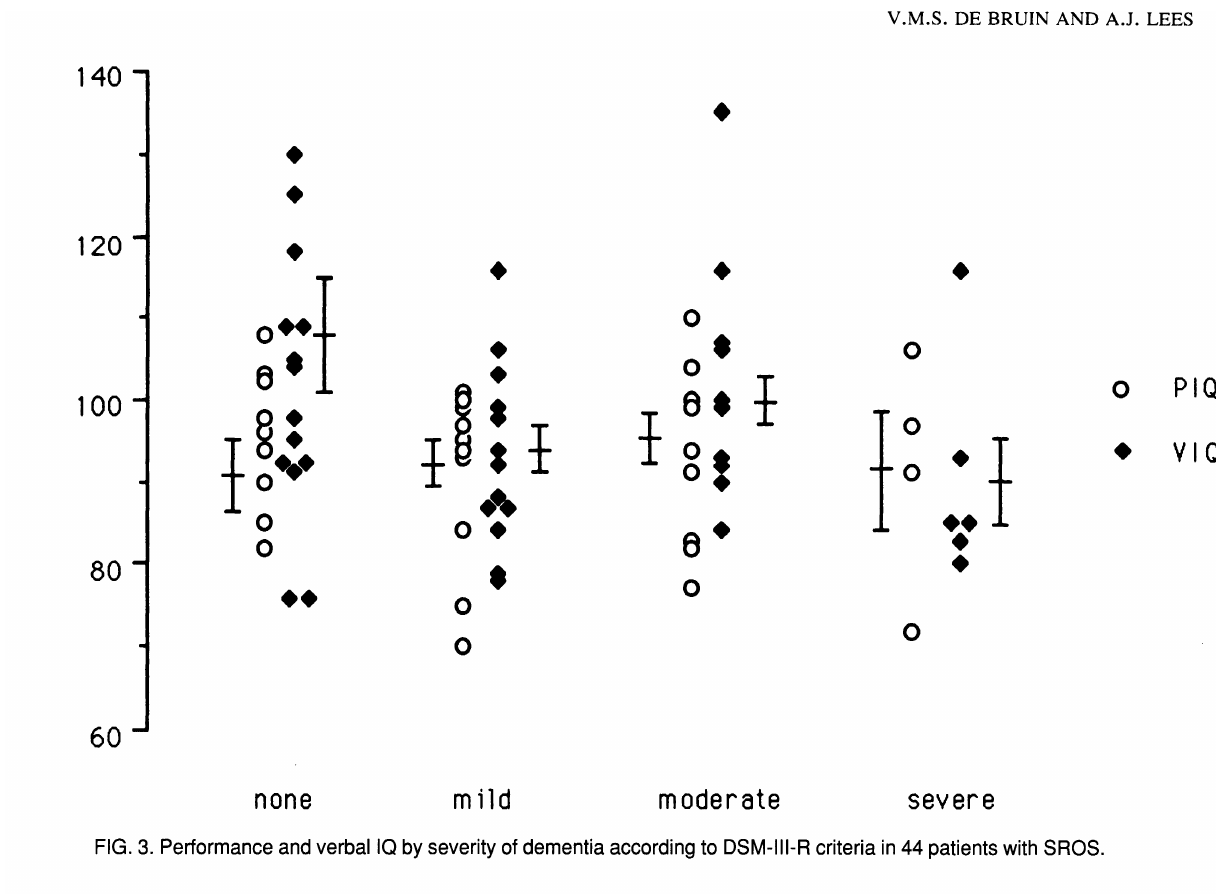
FIG. 3. Performance and verballQ by severity of dementia according to DSM-III-R criteria in 44 patients with SROS.